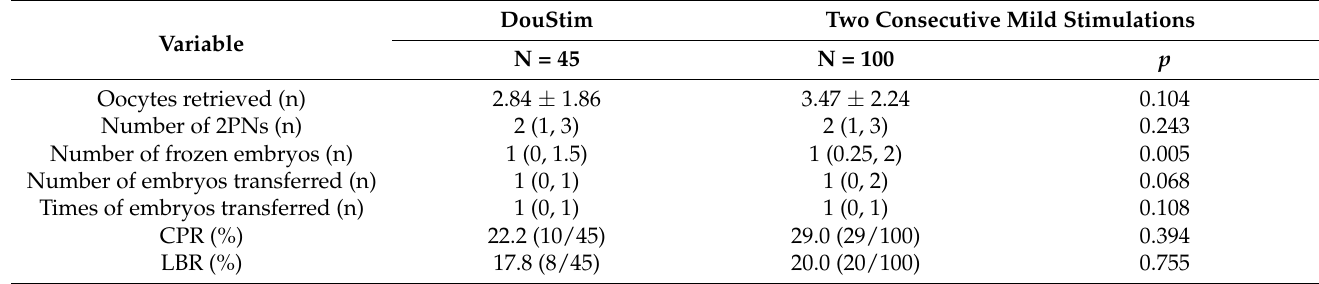
Table 7. Comparison of clinical observation indexes and pregnancy outcomes between the DouStim group and the two consecutive mild stimulations group in elderly POR patients (ages ≥ 35